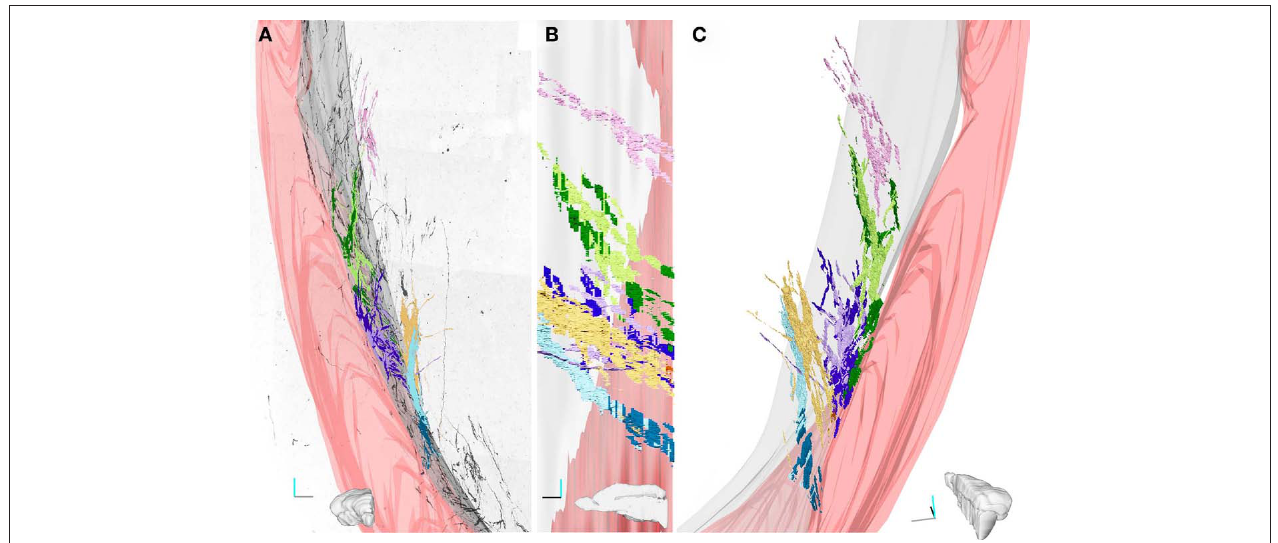
view slightly rotated medially. Only one fascicle (pink) runs exclusively in the striatal parenchyma, while the others run partly inside the EC. The Lilac and green fascicle extend always close to the EC, while the yellow and cyan contact the EC caudally and then turn medially within the striatal parenchyma. The medial surface of the EC is in gray; the surface of a big blood vessel running through the EC is in pink. Orientation Bars: gray line: medial; cyan line: dorsal; dark line: caudal.